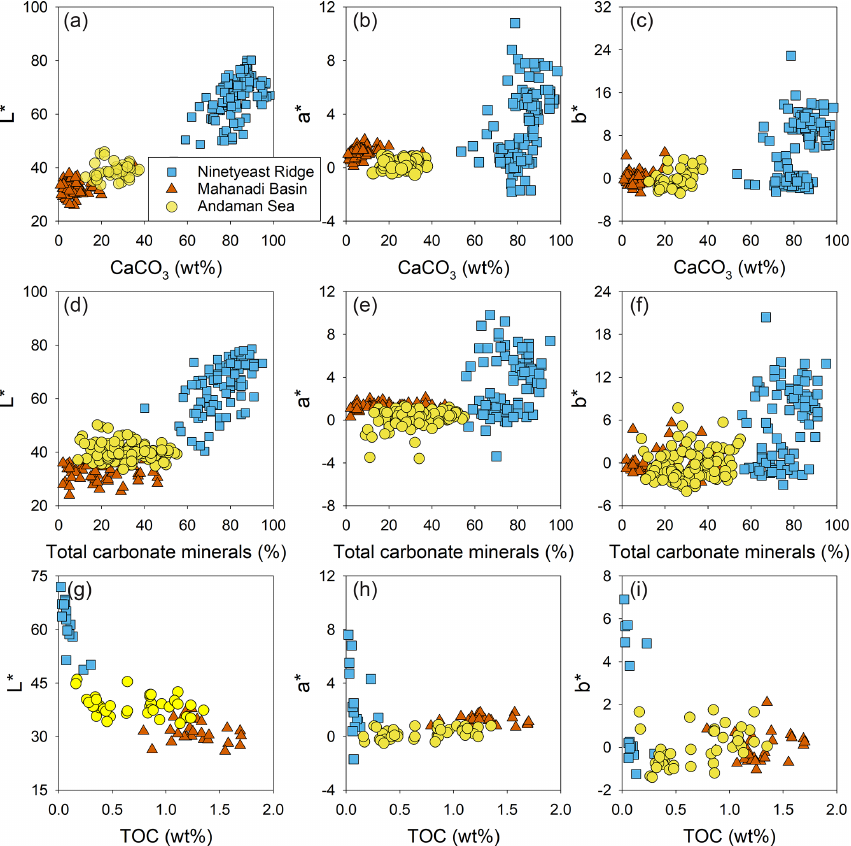
Figure 11. Average sediment lightness (L*) and chromaticity variables (a* and b*) vs. average CaCO 3 % (a–c) , smear slide total carbonate minerals (d–f) and total organic carbon (TOC) % (g–i) from IODP Expedition 353 sites: Ninetyeast Ridge, I. (blue squares) IODP Site U1443, Andaman Sea (IODP Site U1448), and Mahanadi Basin (purple circles) IODP Site U1446. Data from Clemens et al. (2016b, c,